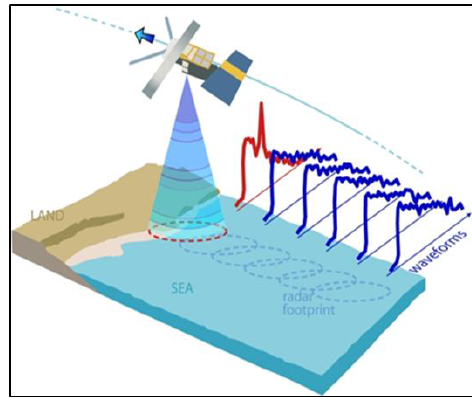
Figure 6: Satellite altimetry waveform in the open ocean (blue) and near coast (red).